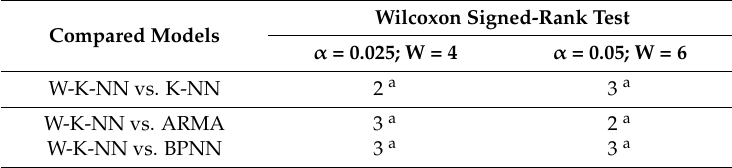
Table 7. Wilcoxon signed-rank test for the small sample.